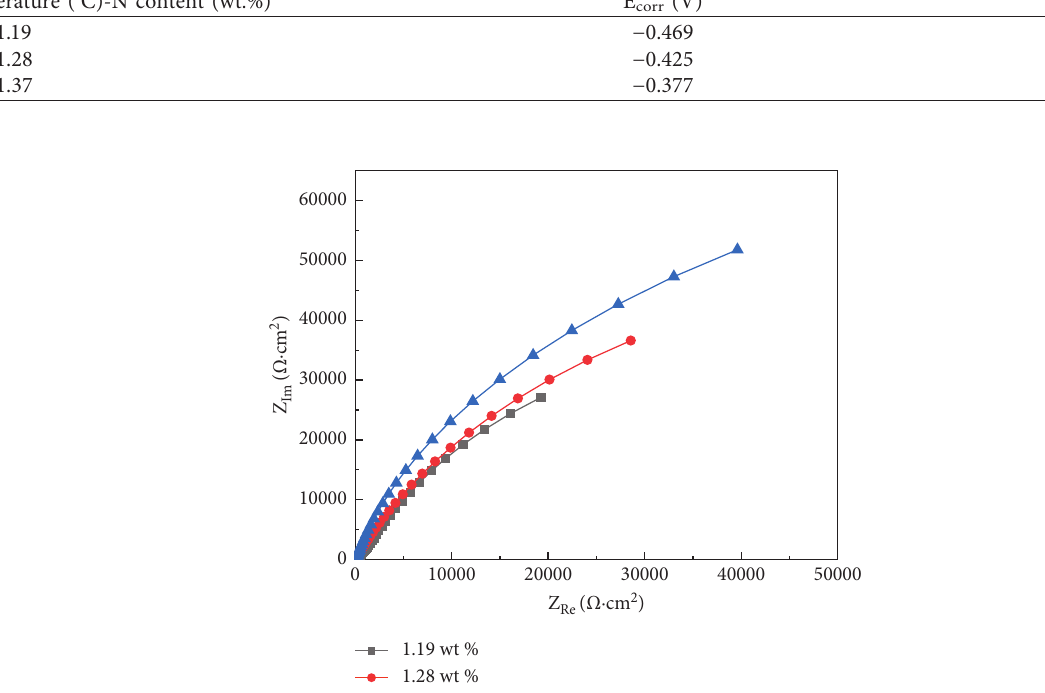
Table 3: Electrochemical parameters of the HNNS samples with different N contents. Temperature ( ° C)-N content